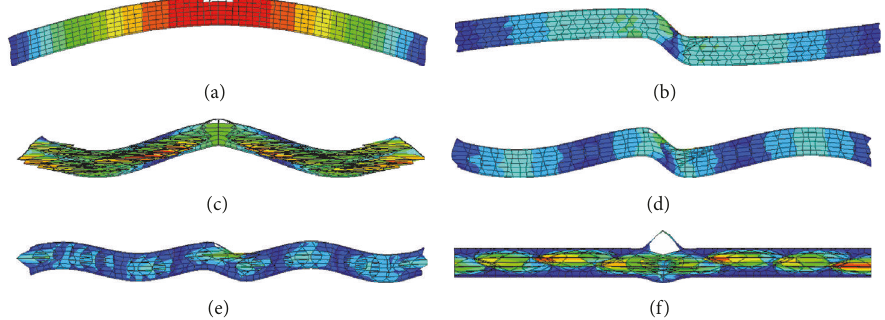
Figure 10: Mode shapes of the debonded sandwich beam corresponding to natural frequencies: (a) 293.07 Hz, (b) 433.67 Hz, (c) 1093.2 Hz, (d) 1132.0Hz, (e) 1769.9 Hz, and (f) 2080.2 Hz.